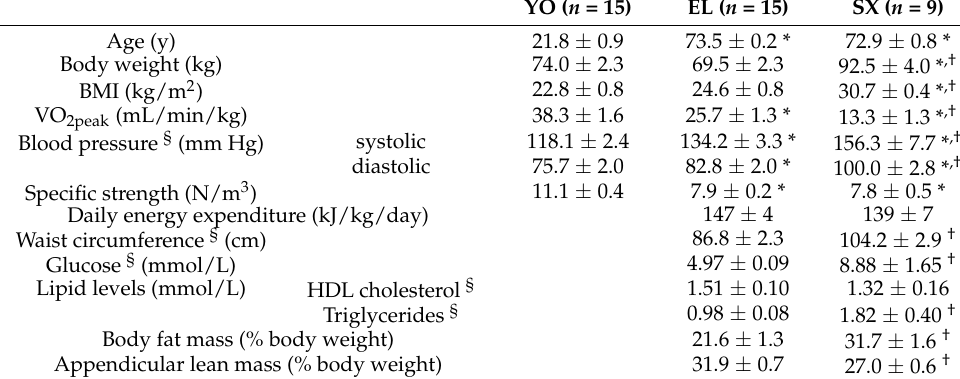
Table 1. Subject